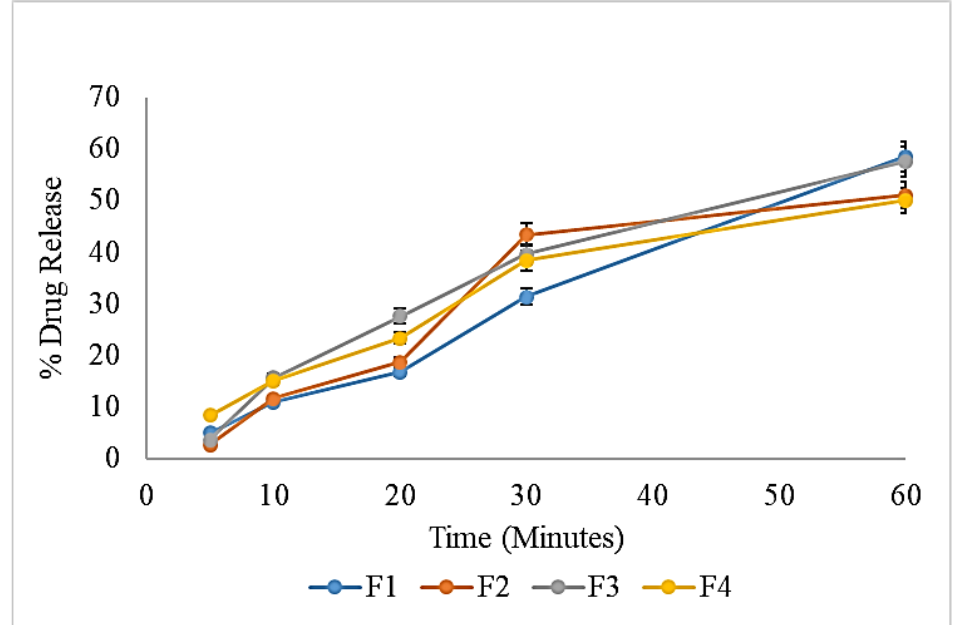
Figure 4. Graphical representation of the drug release studies from the prepared nanoemulsion.